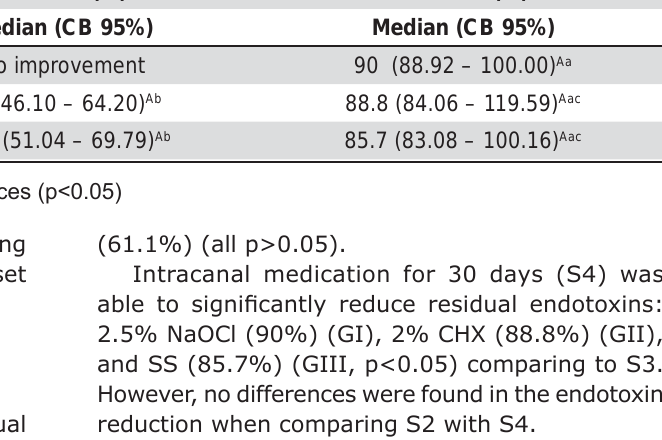
Table 2- Distribution of the median percentage values of endotoxin reduction found in primarily infected root canals after different sampling times